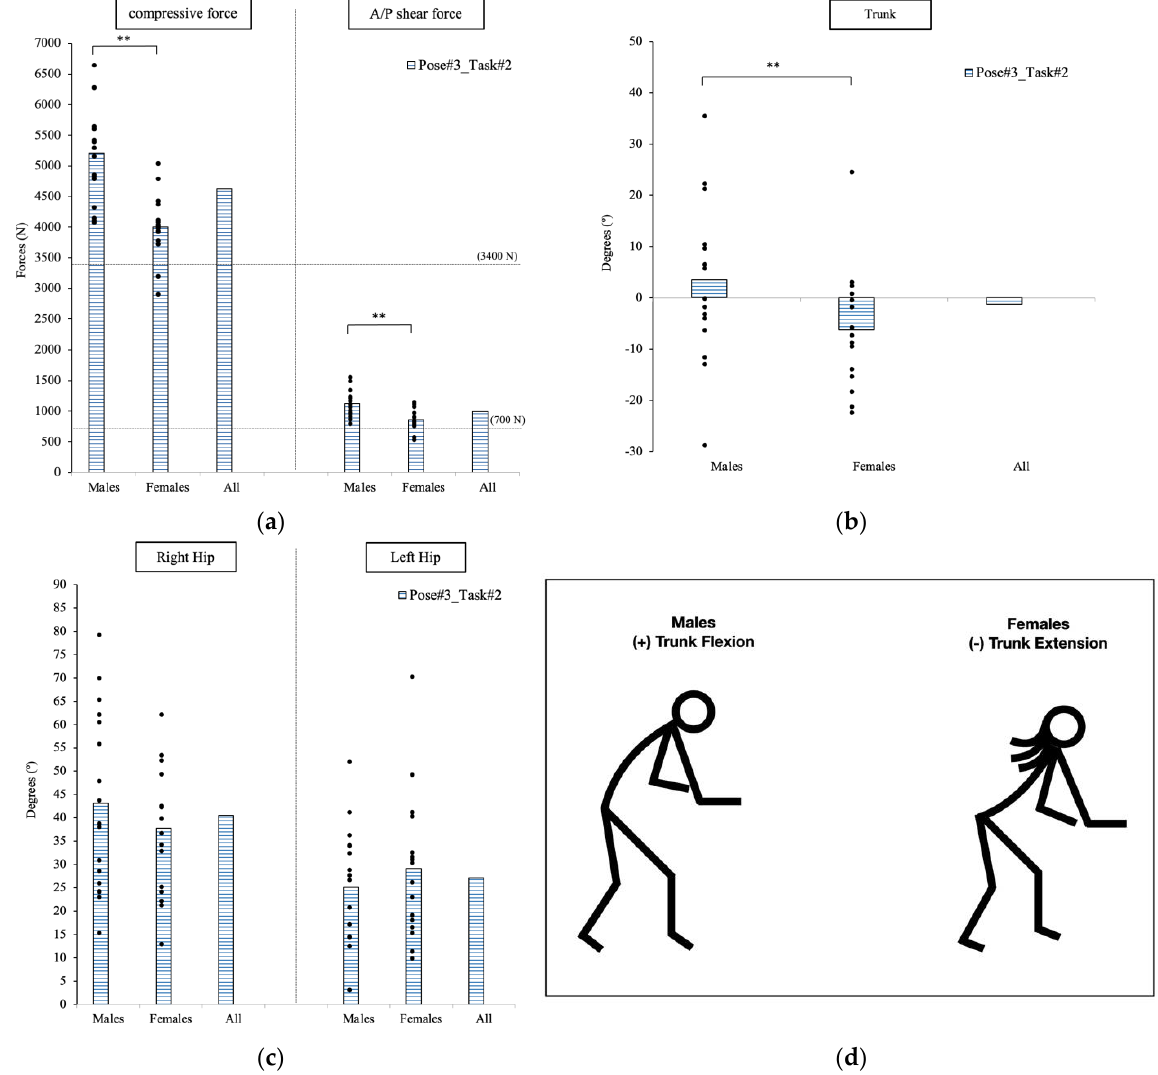
Figure 6. At Pose#3 in Task#2, the forces exposed on the lower back are plotted in ( a ). The trunk joint is plotted in ( b ). The hip joints are plotted in ( c ). Stick figures illustrating the significant difference in postures for males and females are shown in ( d ). ** indicates a significant difference between genders.